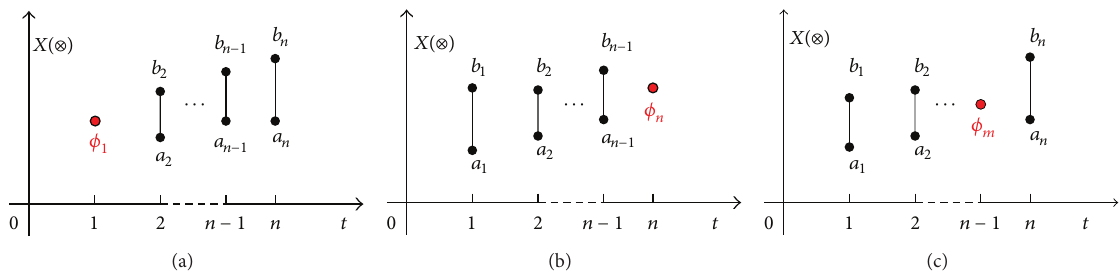
Figure 1: Three forms of interval grey number sequence with a real number.